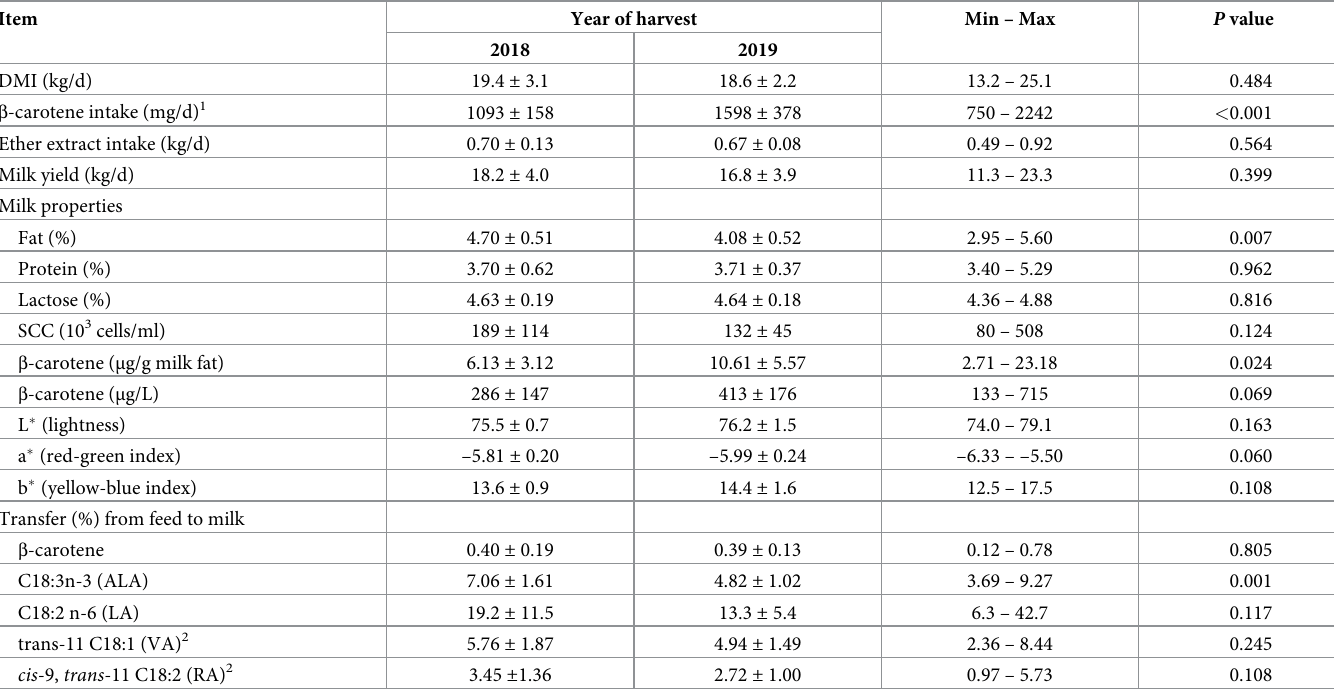
Table 1. Effects of the year of harvest of grassland-based feeds on intake, ether extract digestibility, milk yield and milk properties.